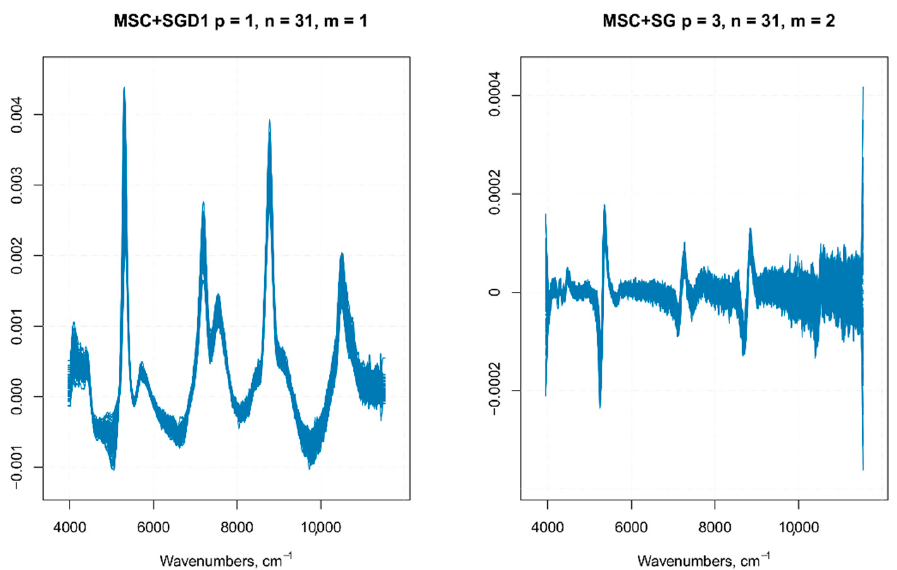
Figure 5. MSC followed by first order Savitzky–Golay derivative (MSC + SG1D) and MSC followed by second order Savitzky–Golay derivative (MSC + SG2D).